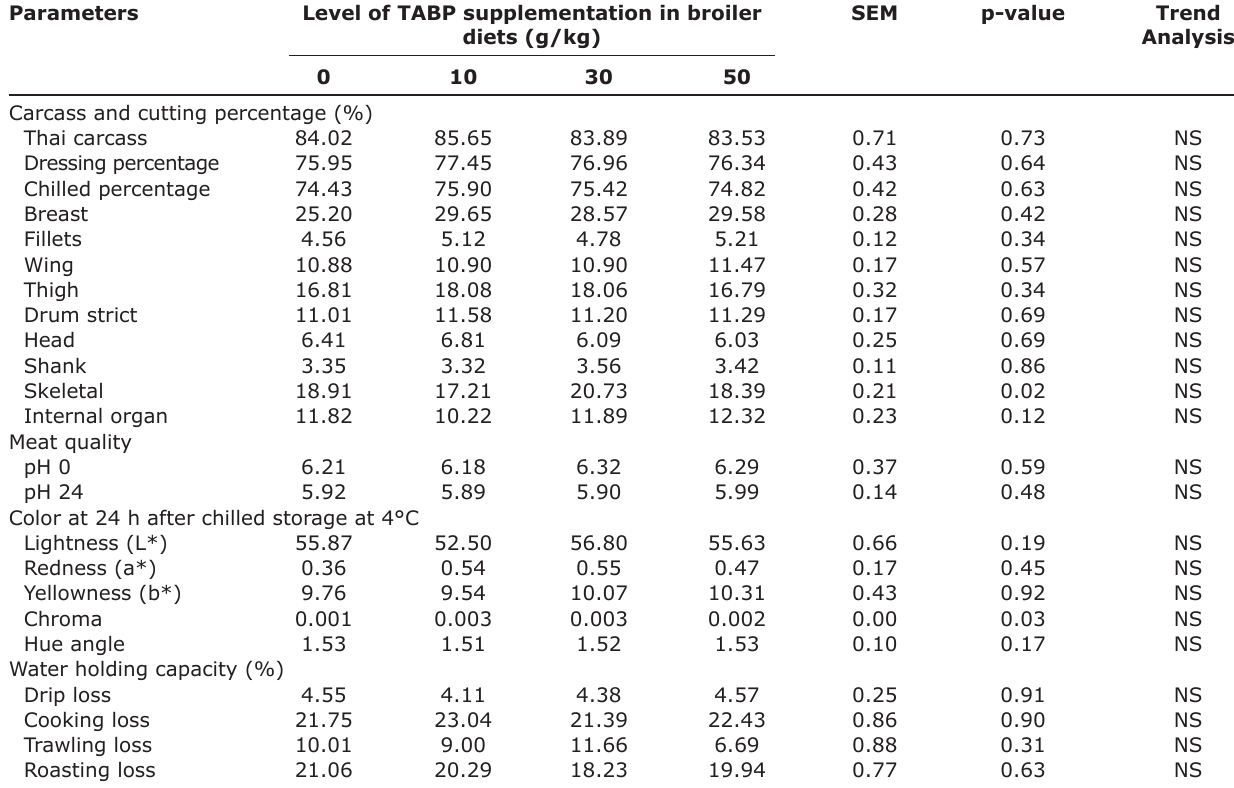
Table-6: Effects of TABP supplementation in broiler diets on carcass and meat quality. Parameters Level of TABP supplementation in broiler